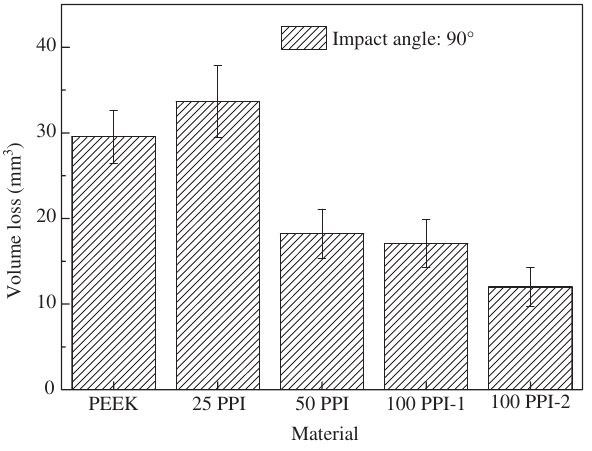
Figure 4: Volume loss results of the different materials with an impact angle of 90 °